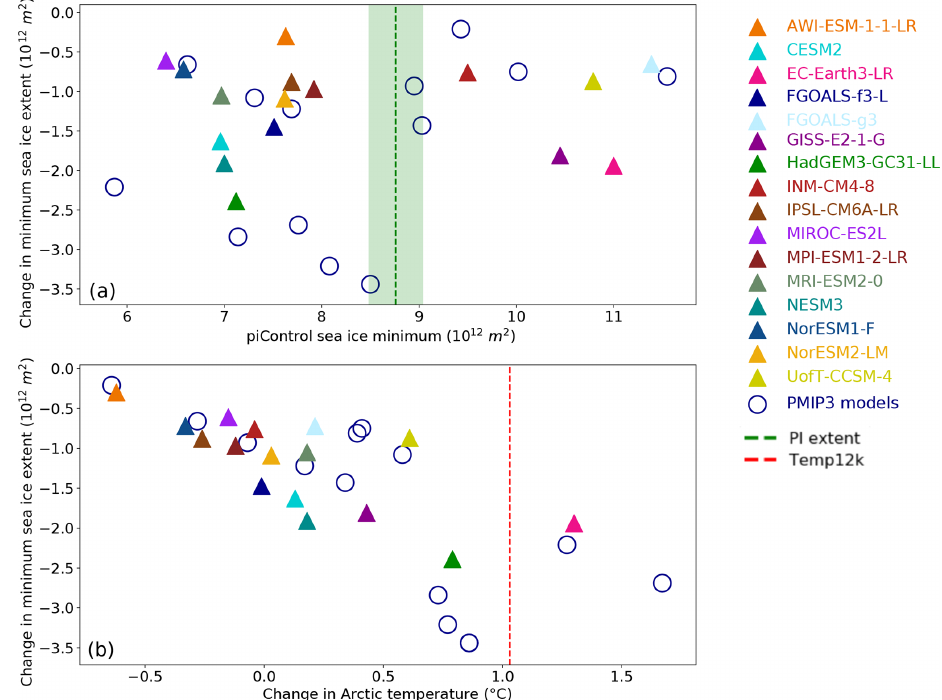
Figure 10. Changes in Arctic sea ice minimum extent. The change in the areal extent of the minimum sea ice cover (i.e. grid boxes with greater than 15% concentration) at the mid-Holocene compared to (a) the minimum sea ice extent in the piControl simulations and (b) the Arctic annual mean temperature change. Observational estimates of the pre-industrial extent (Walsh et al., 2016) and mid-Holocene Arctic warming (Fig. 4; Kaufman et al., 2020a) are also